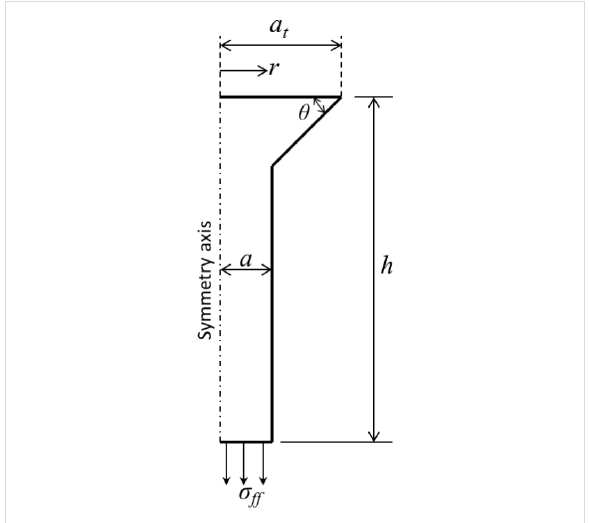
Figure 2: Two-dimensional axial symmetry model for a mushroom-like fiber. The tip (top surface) is fixed in radial direction to simulate full-fric- tion contact. DB cohesive zone model is implemented at the tip of the fiber in FE